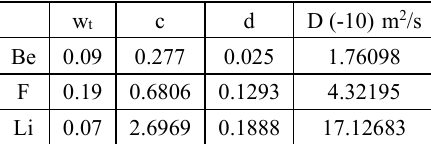
Table 1. Parameters for the effective width model (Effective mass of LiF-BeF 2 =100)